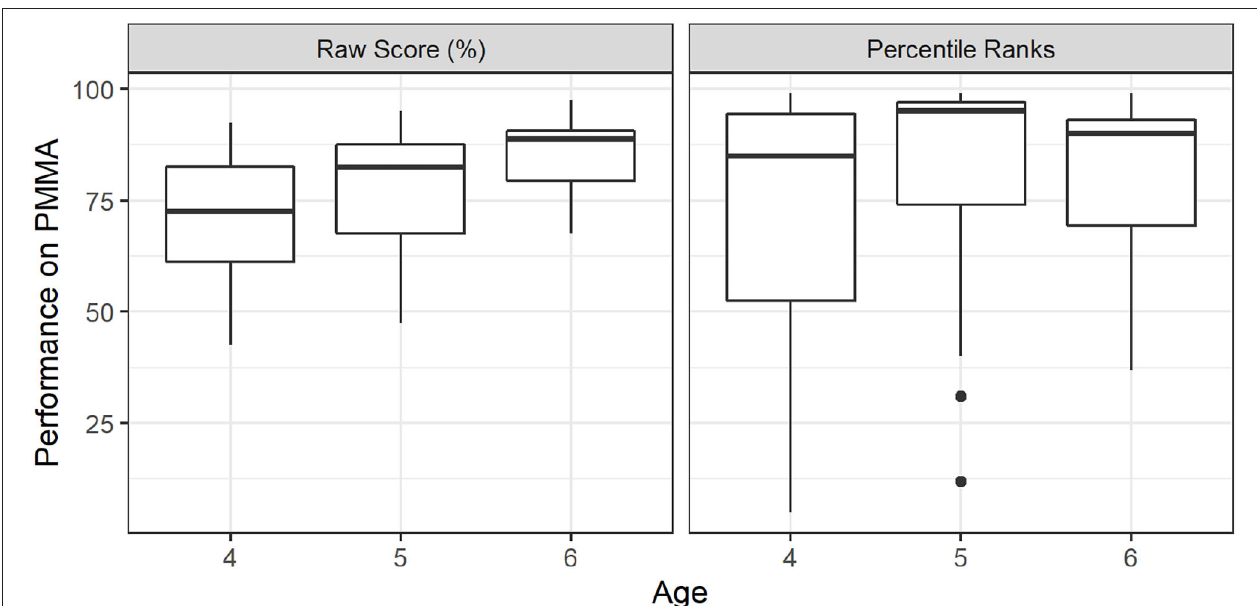
FIGURE 1 | Performance on PMMA musicality test by age. Raw test scores in percentages are shown in the left panel, and grade-based percentile norm ranks in the right. Kruskal-Wallis test on the raw musicality scores yielded significant variation among different ages, [ χ 2 (2, N = 44) = 6.61, p < 0.05]. A post-hoc Dunn’s test with Holm’s multiple comparisons adjustment showed that scores of the 4-year-olds and 6-year-olds differed significantly ( p < 0.05), but score differences between consecutive age groups were not significant. No significant group differences among the age groups were observed in the percentile norm